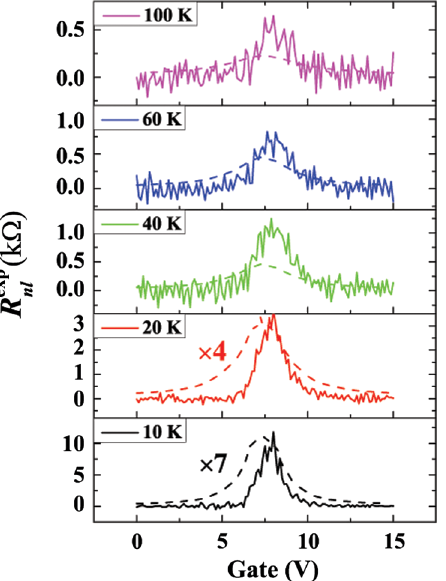
FIG. 11. The measured nonlocal resistance R exp function of gate voltage for different temperatures, as shown by the solid curves. The calculated stray current R 0 dashed curves. The magnitude of R 0 for 10 K and by a factor of 4 for 20 K.